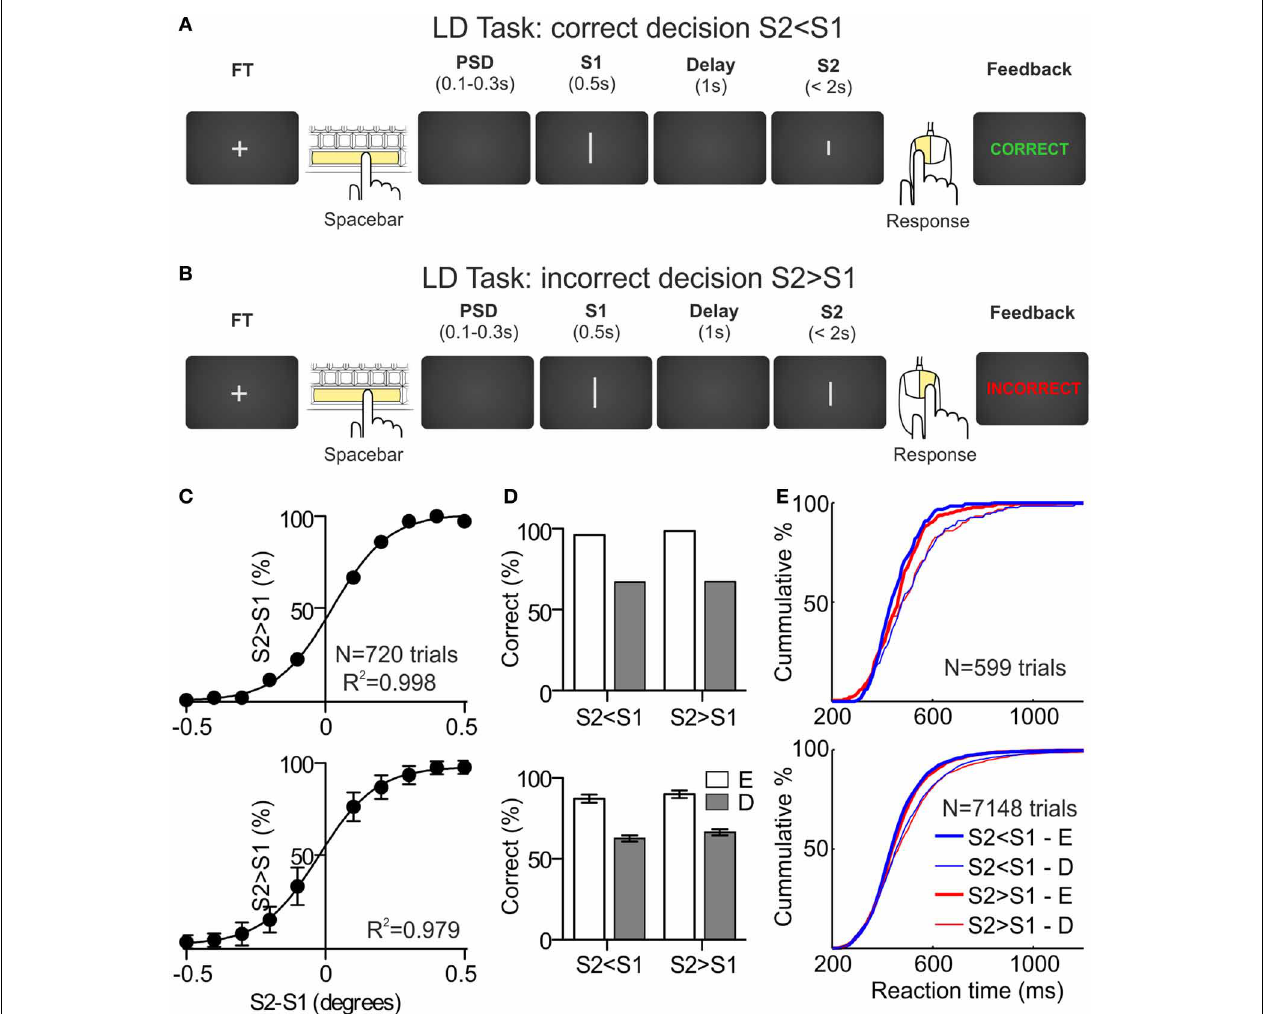
FIGURE 1 | Length discrimination task and behavioral results. (A,B) Sequence of events during a correct and an incorrect trial, respectively, of the length discrimination (LD) task. The fixation target (FT) appears in the center of the monitor screen. The participant initiates the trial by pressing the spacebar and, after a variable pre-stimulus delay (PSD), two stimuli (white lines of variable length. S1 and S2) are presented sequentially, separated by a delay of 1s. The first stimulus is presented for 500ms and the second one remains on screen until the participant indicates, by pressing one of the mouse buttons, whether S2 is larger (right button) or shorter (left button) than S1. After the behavioral response, the participant receives feedback about the correctness of the choice